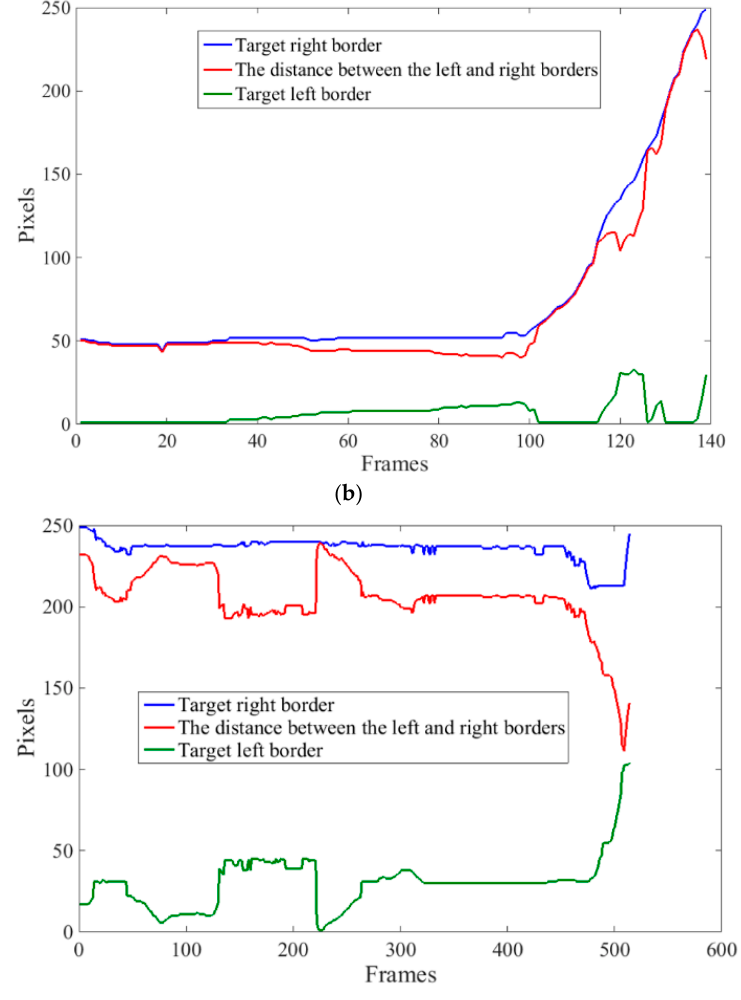
Figure 7. Extraction of behavioral characteristics: ( a ) entering resting area; ( b ) stationary and leaving resting area; and ( c ) stationary and turning around.